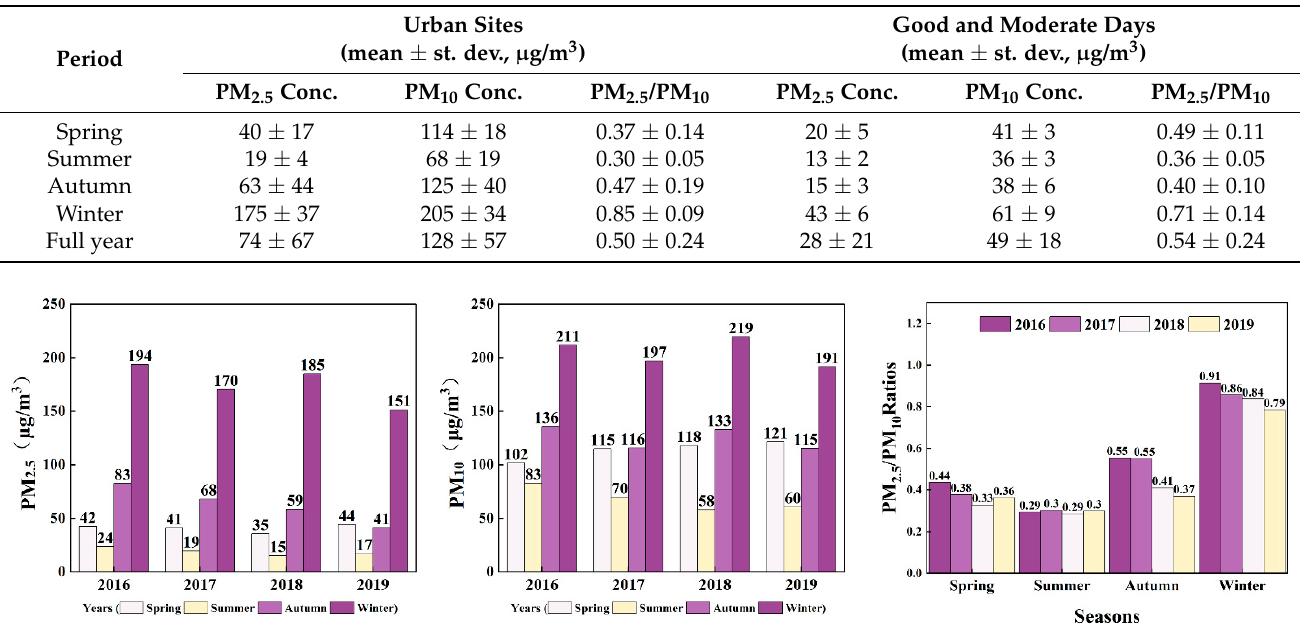
Table 3. Four-season average PM concentrations and PM 2.5 /PM 10 ratios from 2016 to 2019 in UB.